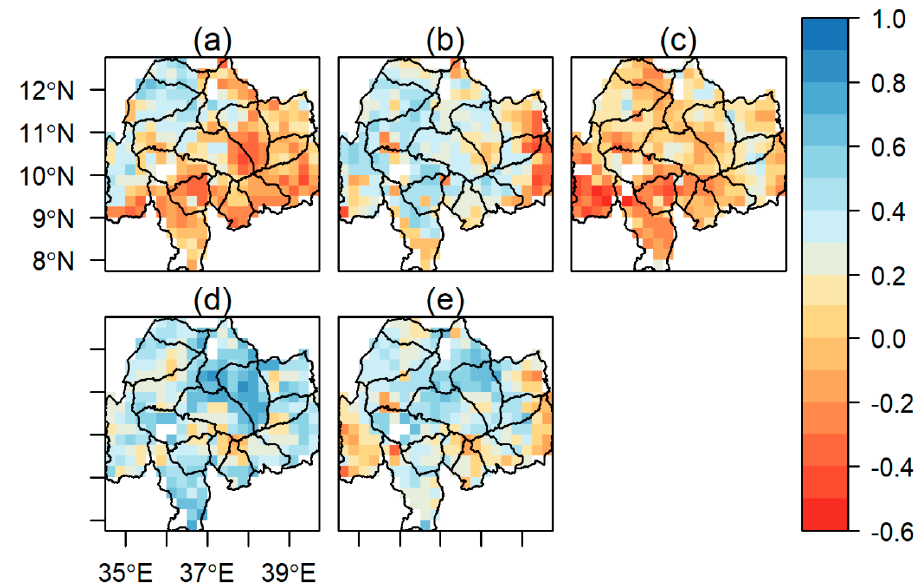
Figure 11. Pearson correlation (r ranging from − 1 to 1) between ASM and rainfall for ( a ) winter, ( b ) spring, ( c ) summer, ( d ) autumn season, and ( e ) annually (1992 to 2017). The correlation coefficient (r ≥ |0.39|) is significant at p < 0.05.